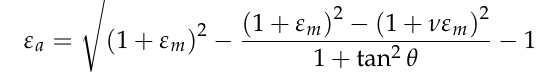
Figure 4. Strain of ( a ) y-direction and ( b ) x-direction.